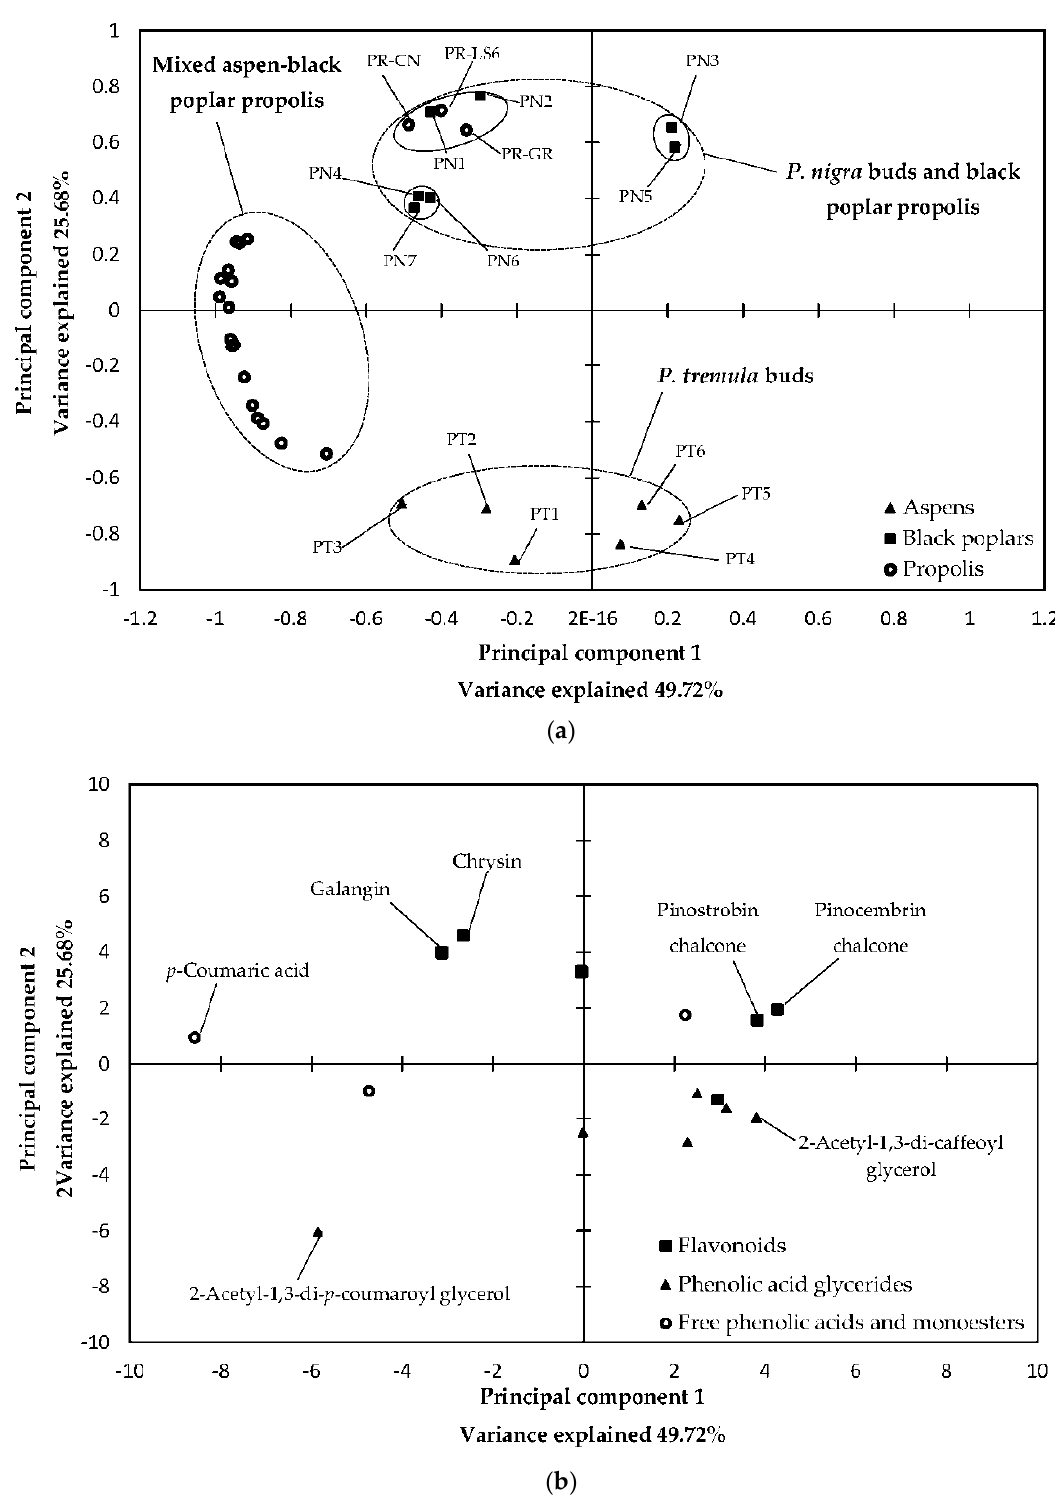
Figure 1. PCA of 70% ethanol in water extracts analysis: score plot ( a ); and load plot ( b ).